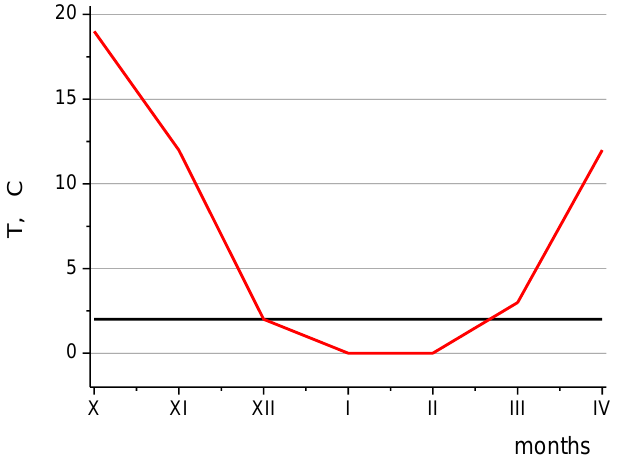
Figure 2. A sample external temperature distribution in Kielce, Poland, during the heating season.